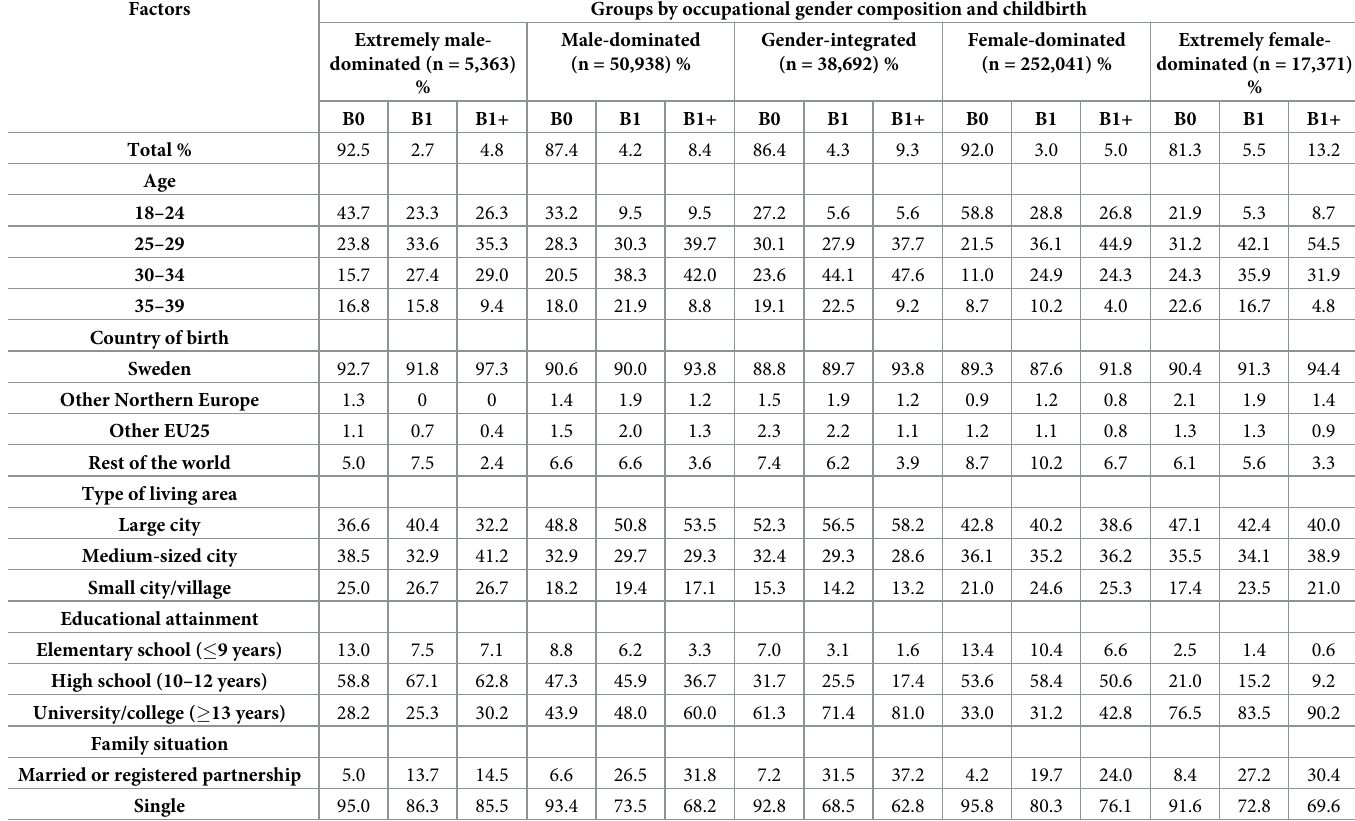
Table 1. Cohort characteristics by occupational gender composition and childbirth (N =